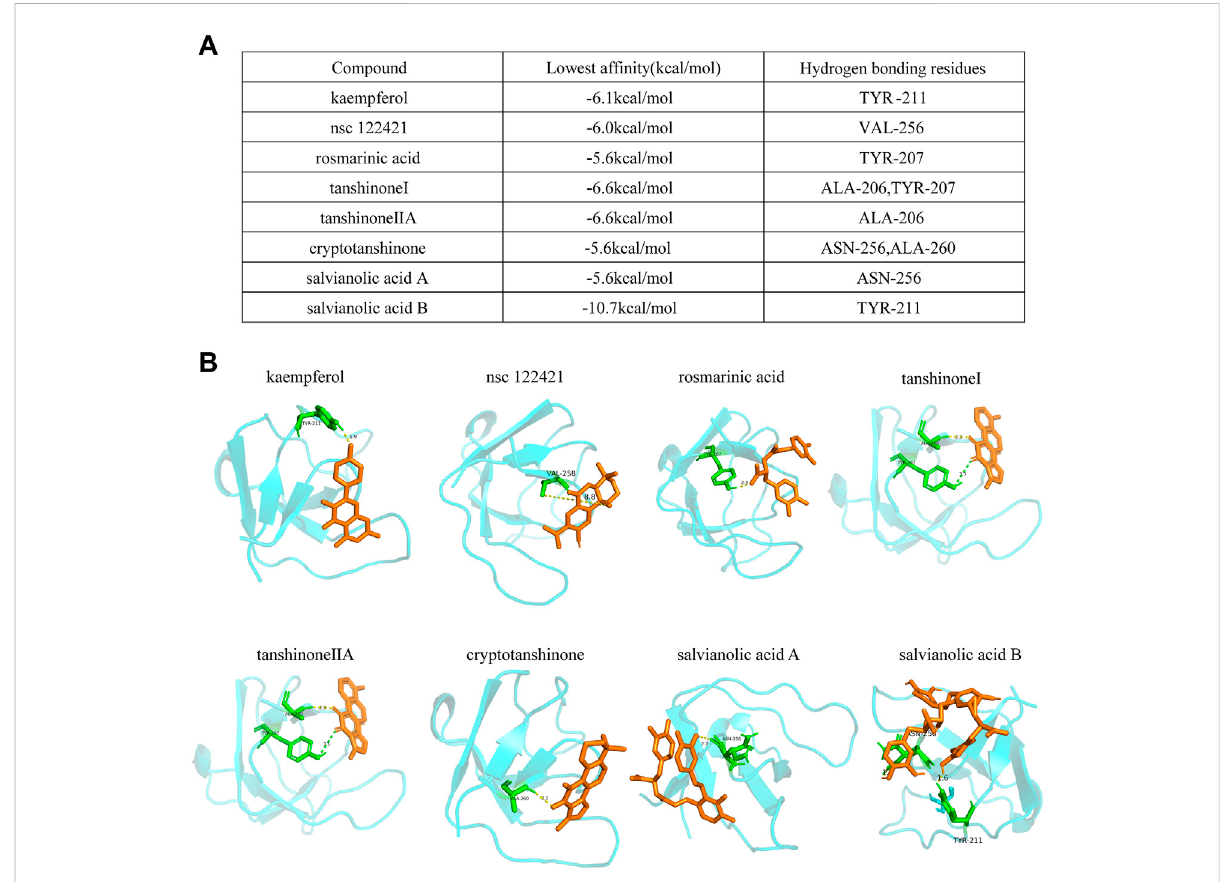
FIGURE 6 Docking simulations of bioactive ingredients with LASP1 molecule. (A) The binding af fi nities and the hydrogen bonding residues are shown. (B) The docking graph is